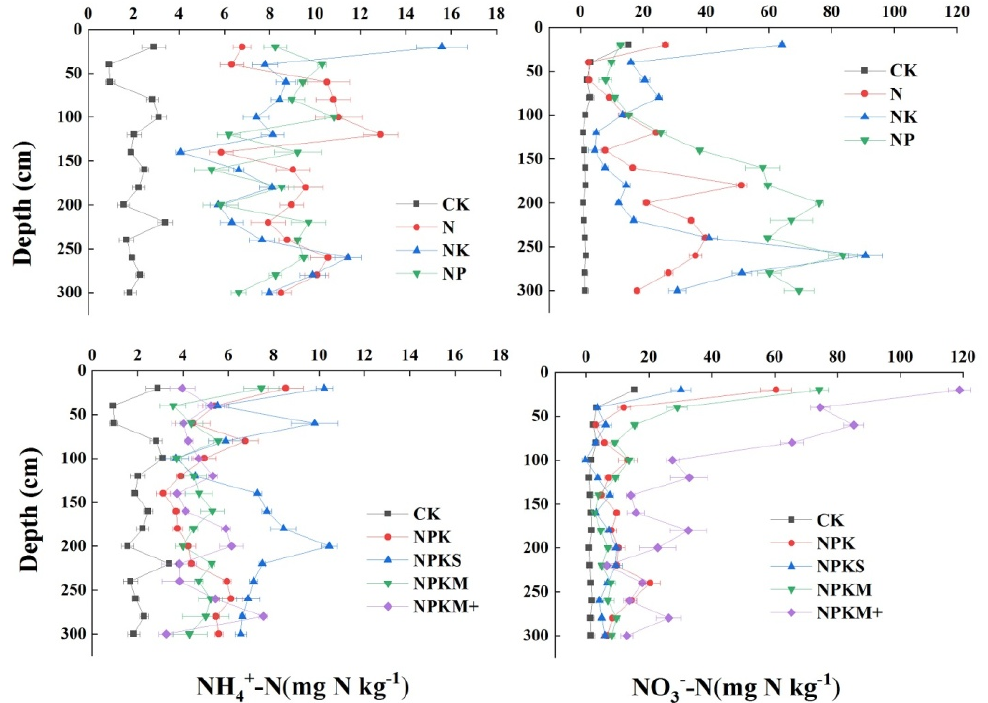
Figure 3. Distribution of NO 3 − -N and NH 4+ -N after the maize harvest in 2014 in the 24 years of experimentation in a gray desert soil cropland. Bars indicate error of the mean, n = 3.